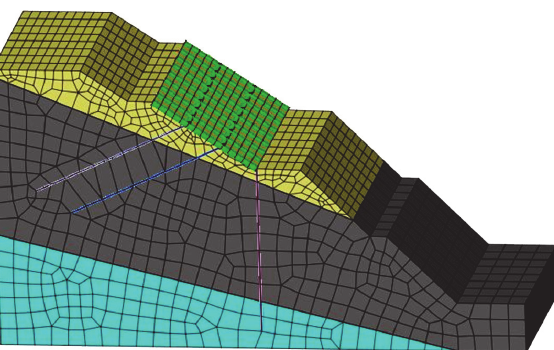
Figure 4: FEM 3D numerical